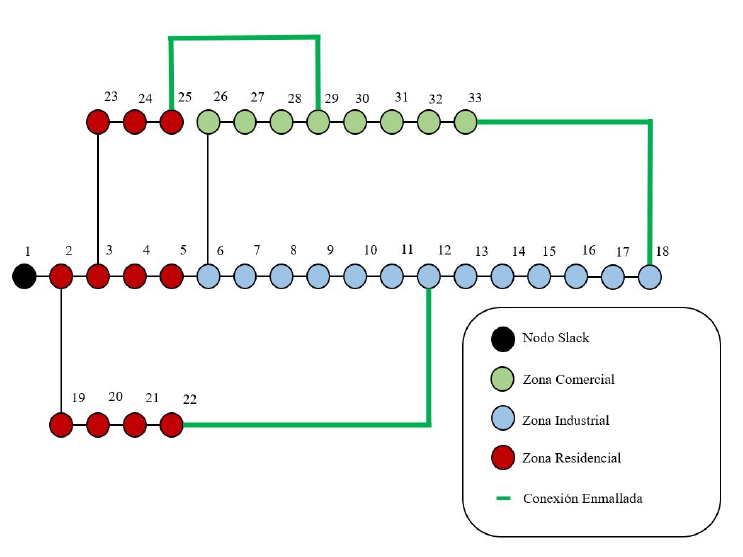
Figure 2. Electrical configuration of the IEEE 33-node system. As for the parametric information of the network, the peak consumption data at each demand node are presented in Table 2. Table 2. Impedance and demand data for the IEEE 33-node